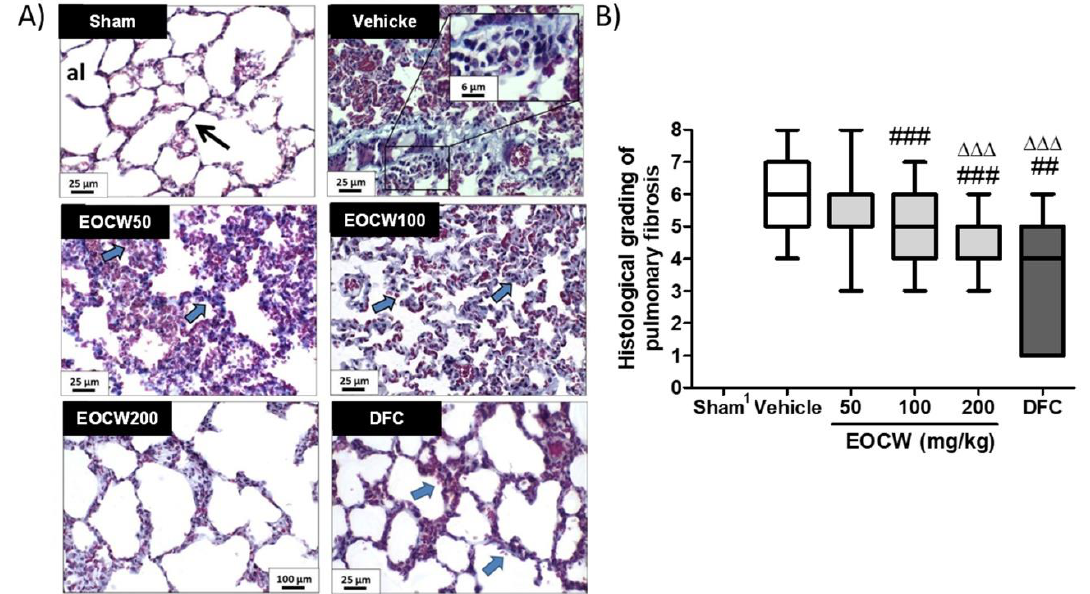
Figure 3. ( A ) Histological features observed in the pulmonary tissue of the experimental groups. Typical regular alveolar spaces (al), with thin septa, are seen in group Sham, whereas groups Vehicle and EOCW50 show thickened septa and fibrotic collapsed alveoli (hyperplasia of type II pneumocytes in detail). Partially obliterated alveoli and alveolar septa of variable thickness are seen in group EOCW100. Wider and more regular alveoli, with thin septa, are observed in groups EOCW200 and DFC (Masson’s trichrome, 400×). ( B ) Assessment of the modified Ashcroft scale of histological gradation of the bleomycin-induced pulmonary fibrosis in the experimental groups. Data are expressed as median, interquartile range, and maximum and minimum values. Significant differences compared to group Vehicle are expressed as ## p < 0.01 and ### p < 0.001; significant differences compared to group EOCW50 are expressed as ΔΔΔ p < 0.001 (Kruskal–Wallis and Dunn’s multiple comparisons test).